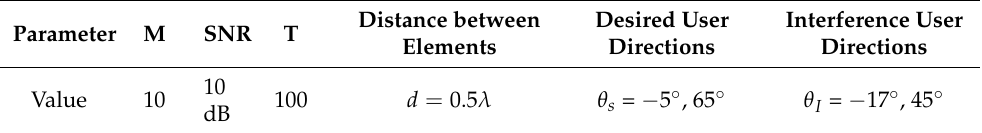
Table 4. The simulation parameters of the first scenario.